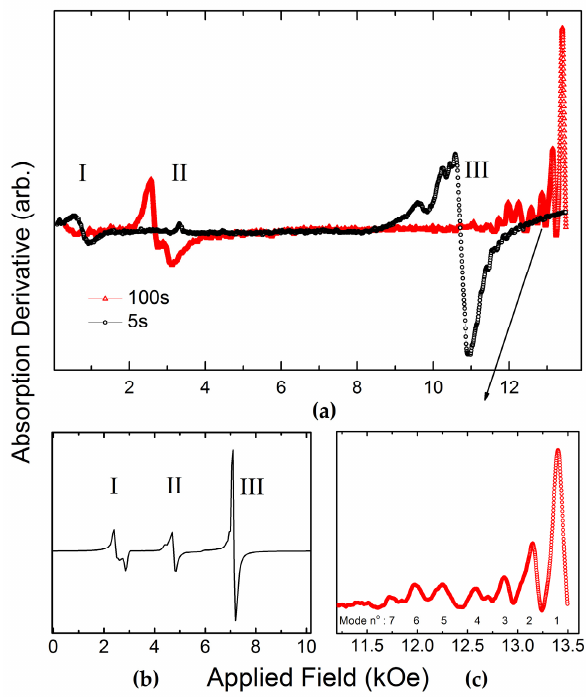
Figure 6. ( a ) Perpendicular ferromagnetic resonance measured in samples electrodeposited for 5 s and 100 s; ( b ) dynamic micromagnetic simulation results for the unpercolated model as presented in Figure 3 and ( c ) a zoomed view of standing spin wave modes that are well defined in the percolated sample.